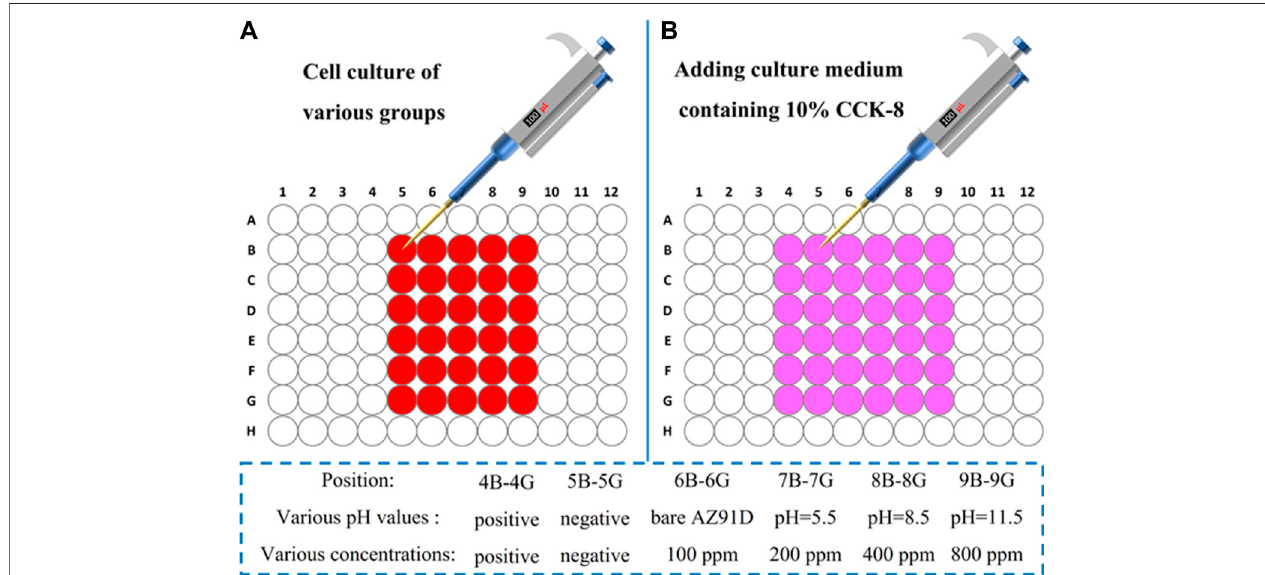
FIGURE 1 | Instruction of cytotoxicity